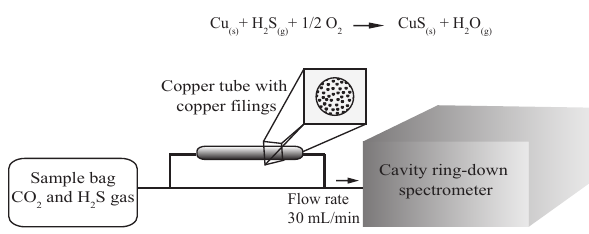
Figure 1. Diagram showing the H 2 S experimental setup. A sample bag containing a standard gas with known CO 2 concentration and isotopic composition was spiked with various amounts of H 2 S. The gas mixture was run directly into the CRDS to observe the interfer- ence, and then it was run through a copper tube filled with copper filings to ensure that H 2 S was removed and the isotopic value re- turned to that of the standard. Copper reacts with hydrogen sulfide, precipitating copper sulfide and releasing water. This can be ob- served by an increase in the water content measured by the CRDS after a sample has been run through the copper